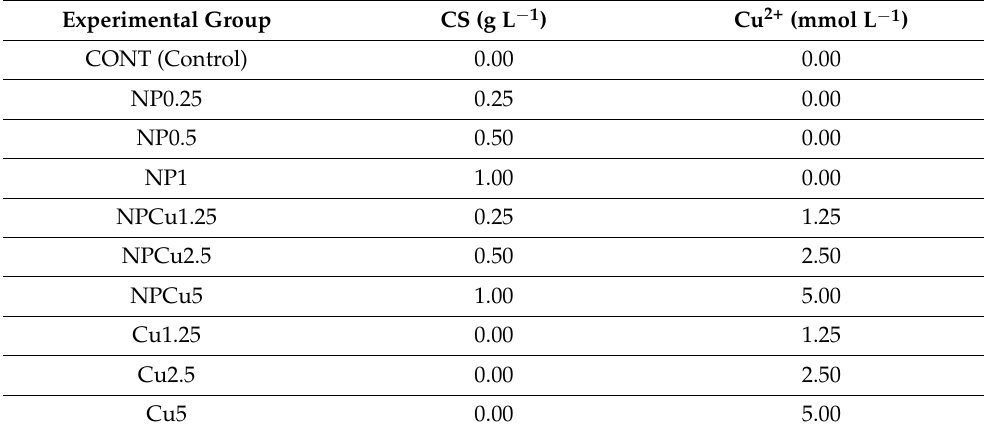
Table 1. Treatments applied to leaf discs and their corresponding chitosan (CS) and Cu 2+ concentrations. Experimental Group CS (g L − 1 ) Cu 2+ (mmol L − 1 ) CONT (Control) 0.00 0.00 NP0.25